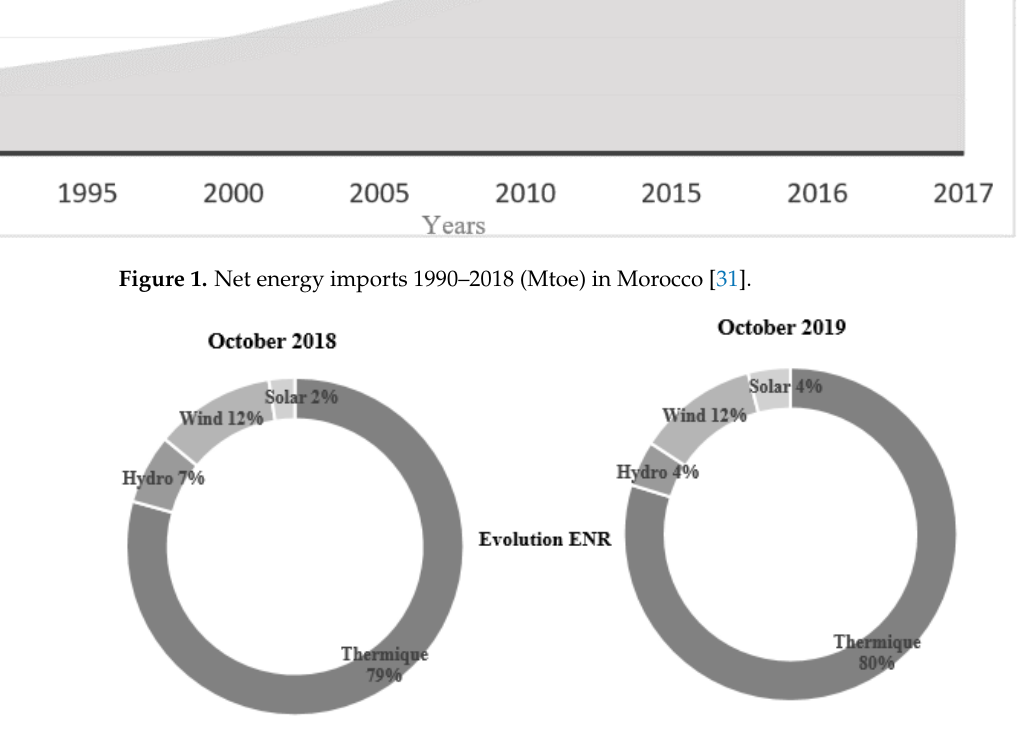
Figure 2. Dynamic share of Renewable energies in Morocco (source: author investigation on national reports).